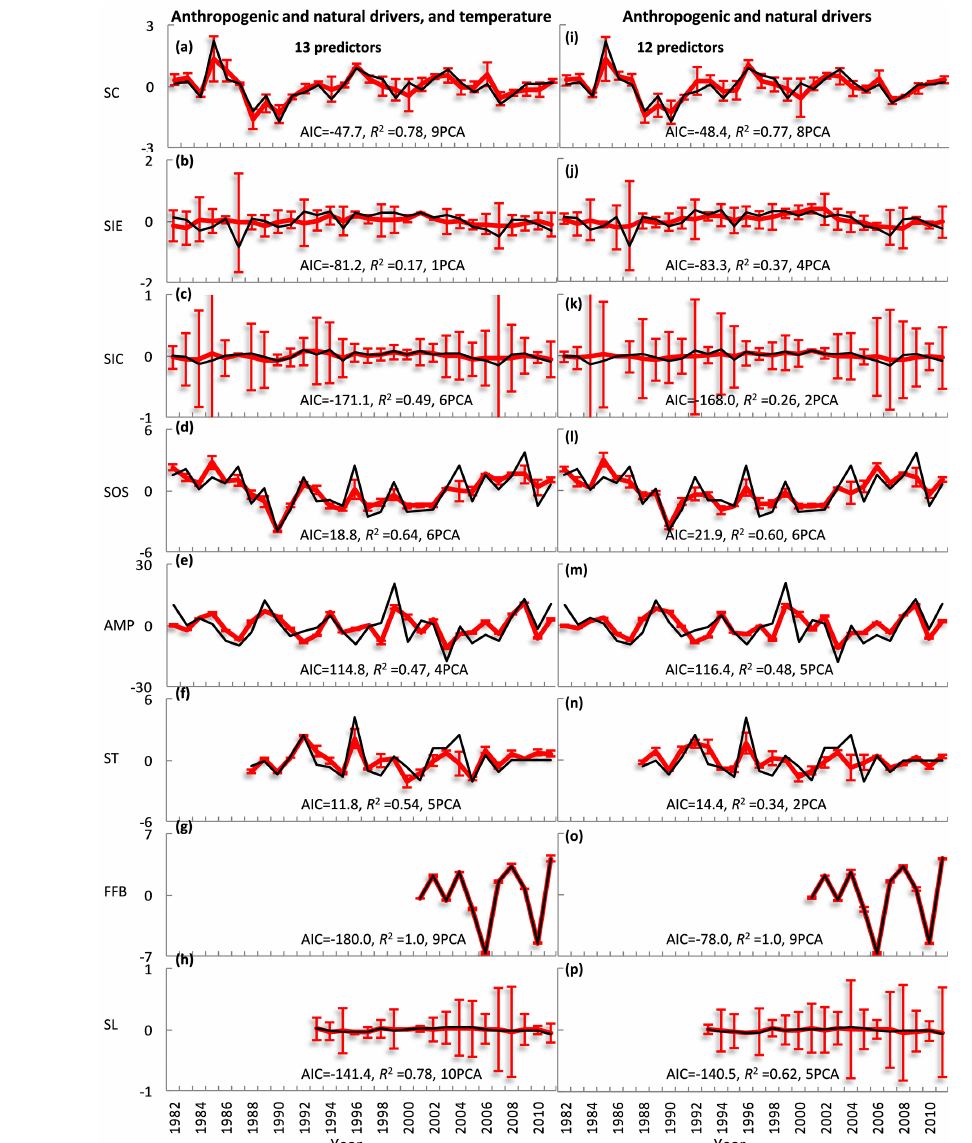
Figure 5. Predicting powers of temperature mediated natural and anthropogenic drivers (left), and only natural and anthropogenic drivers (right). Black line is observed and red line is predicted. Error bars are uncertainty of each prediction measured by standardized error. The predictions were conducted using stepwise regression with Akaike information criterion (AIC) from orthogonal variables transformed by principal component analysis (PCA) against each land, cryosphere and ocean indicator. The number of PCAs selected using the AIC criteria are shown in each panel. Predictors on left panels include the orthogonally transformed PCA variables of temperature, concentration (PPM) of atmospheric CO 2 at Point Barrow, 20 global well-mixed greenhouse gases (WMGHG) radiative forcing, solar radiation, sunspot numbers and eight leading Northern Hemisphere teleconnection indices. Panels on right include all the predictors on the left with exclusion of temperature. Each PCA for the two sets (i.e. left and right panels) were conducted